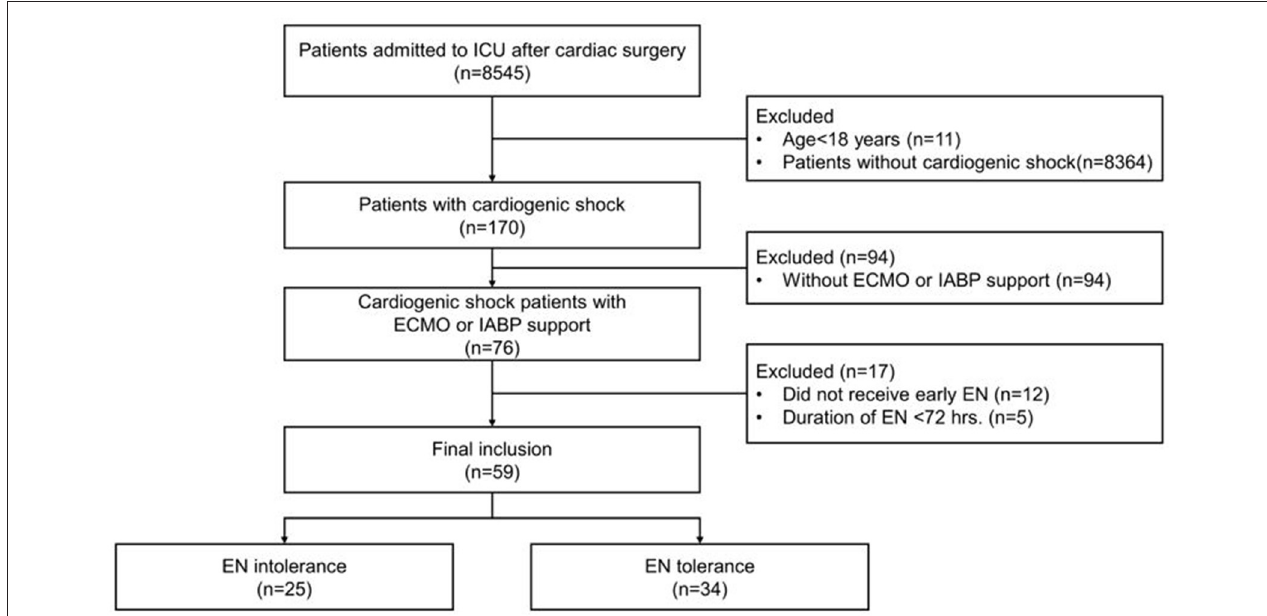
FIGURE 1 | Flowchart of patient selection. ICU, intensive care unit; EN, enteral